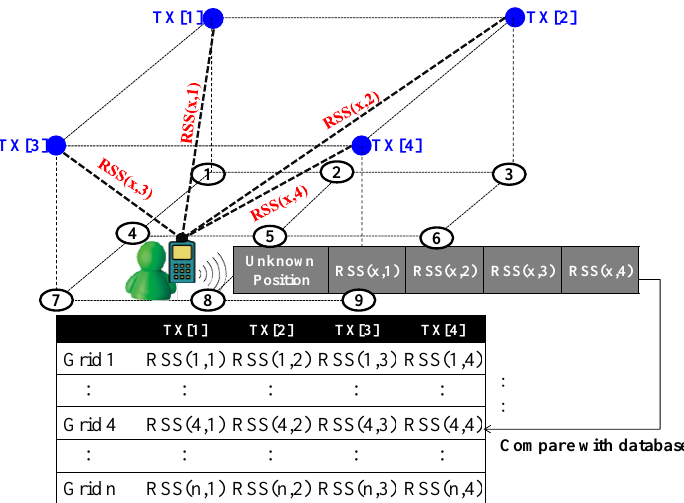
Figure 2. The verification stage of the fingerprinting